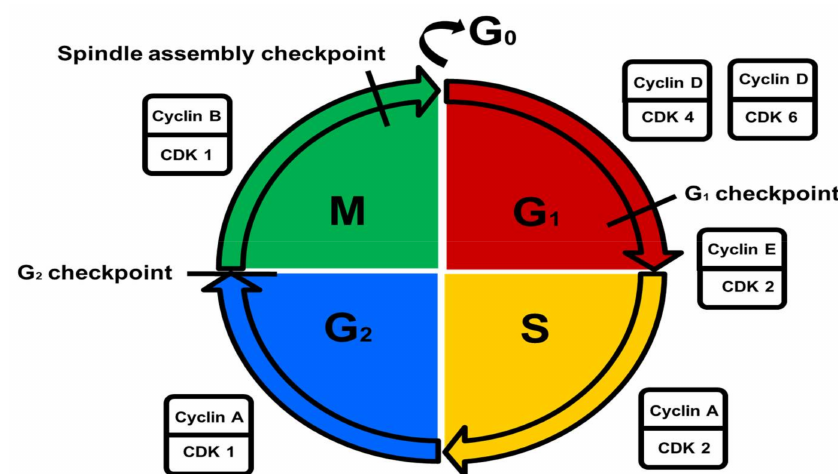
Figure 1. Control of the cell cycle. Metabolically active growing cells are present in the growth 1/gap 1 (G 1 ) phase. DNA replication occurs in the DNA synthesis (S) phase. Cells prepare for mitosis in the pre-mitotic/gap 2 (G 2 ) phase. Cells undergo nuclear- and cytoplasmic division in the mitotic (M) phase. Non-dividing cells exit the cell cycle in the resting (G 0 ) phase. The different cell cycle phases are regulated by specific cyclin/cyclin-dependent kinase (CDK)